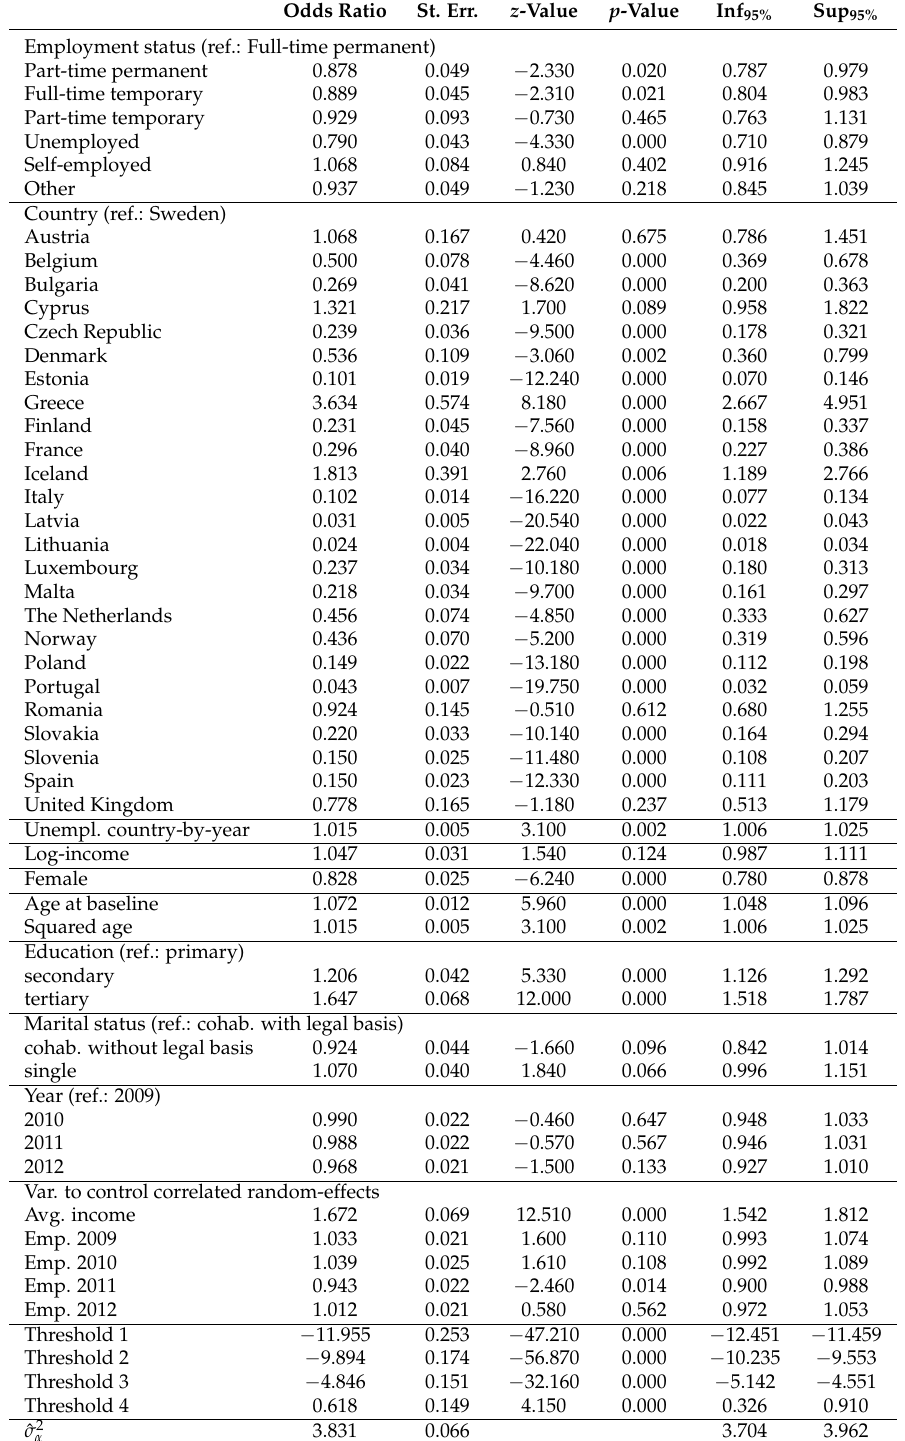
Table 5. Correlated random-effects ordered logit model without economic deprivation —All countries (Log-likelihood = − 72,016.849; ICC = 0.538; AIC = 144,129.70; BIC = 144,523.29). Odds Ratio St. Err. z -Value p -Value Inf 95% Sup 95% Employment status (ref.: Full-time permanent) Part-time permanent